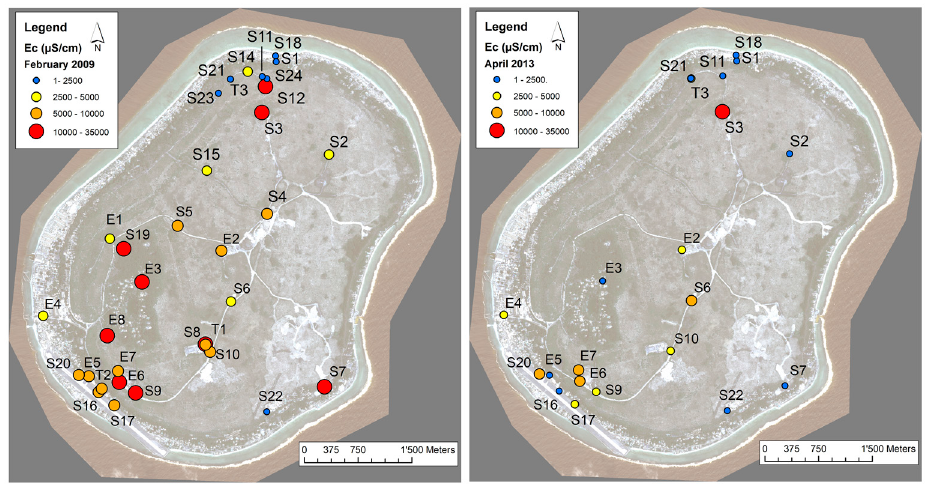
Figure 7. The 2009 and 2013 Electric Conductivity values at the water table into the Nauru aquifer.